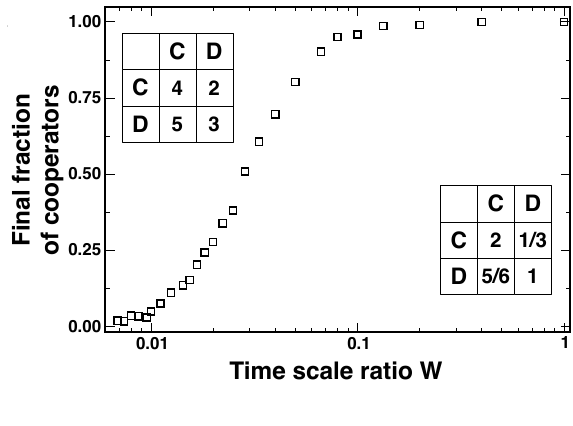
Figure 3. AL changes the nature of the game, even outside the time scale separation limit. We start from 50% cooperating individuals. For small W , C’s never reach fixation. But already for W = 0 . 1 , fixation of C’s is almost certain. Thus, moderate AL is sufficient to turn cooperation into the dominant strategy here. Results are averages over 100 realizations. = 0 . 16 , γ = 0 . 80 and γ = 0 . 32 ). Figure ( N = 100 , β = 0 . 05 , c = 0 . 16 , γ CC CD DD reproduced from